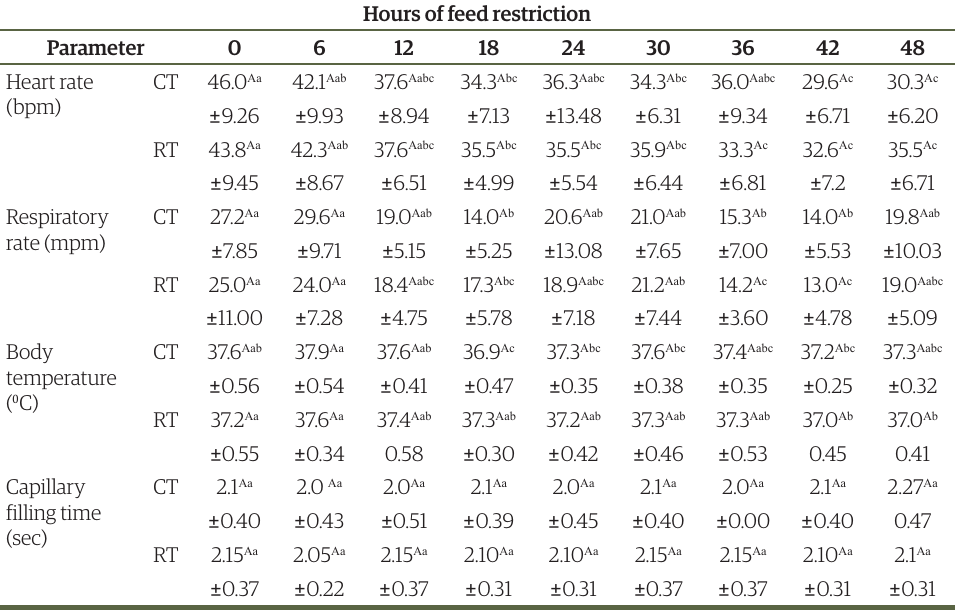
SD of physical parameters of horses during feed restriction (RT) for 48 h and control horses (CT). ±